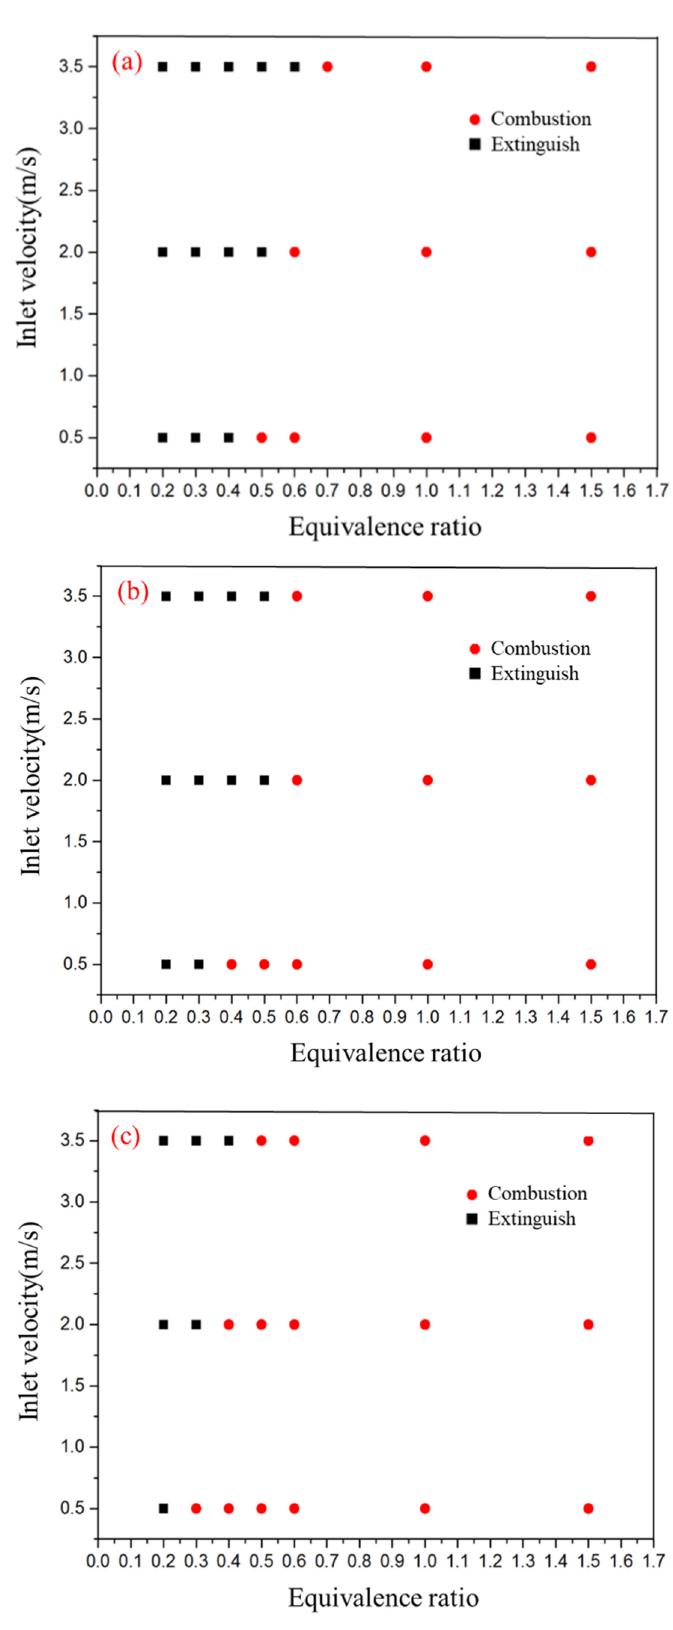
Figure 14. Lean flammable limit. ( a ) MC-U20, ( b ) MC-10/30-0.8, ( c ) MC-20/30-0.5.